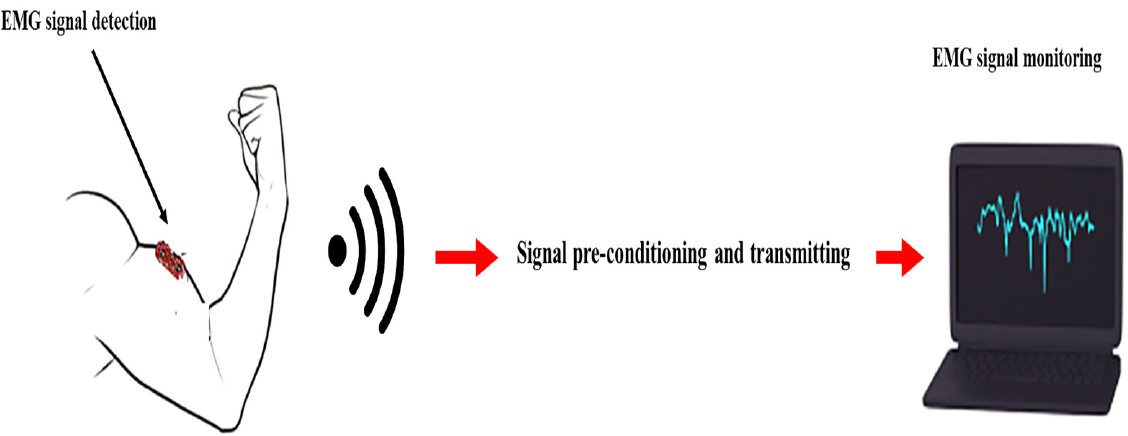
Figure 4. EMG monitoring system structure.